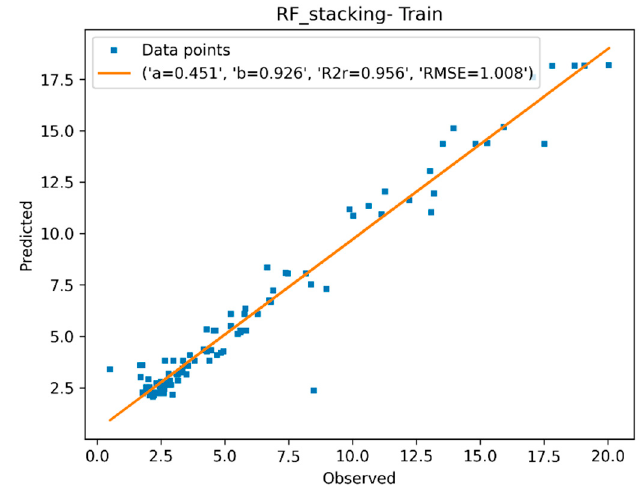
Figure 8. Quantitative structure-property relationship (QSPR) for the logarithm values of equilibrium constants for Eu 3+ complexation: observed vs. predicted affinity constant logarithms (LogK) of Eu 3+ complexation for the training set while using the Random Forest (RF)-stack model.